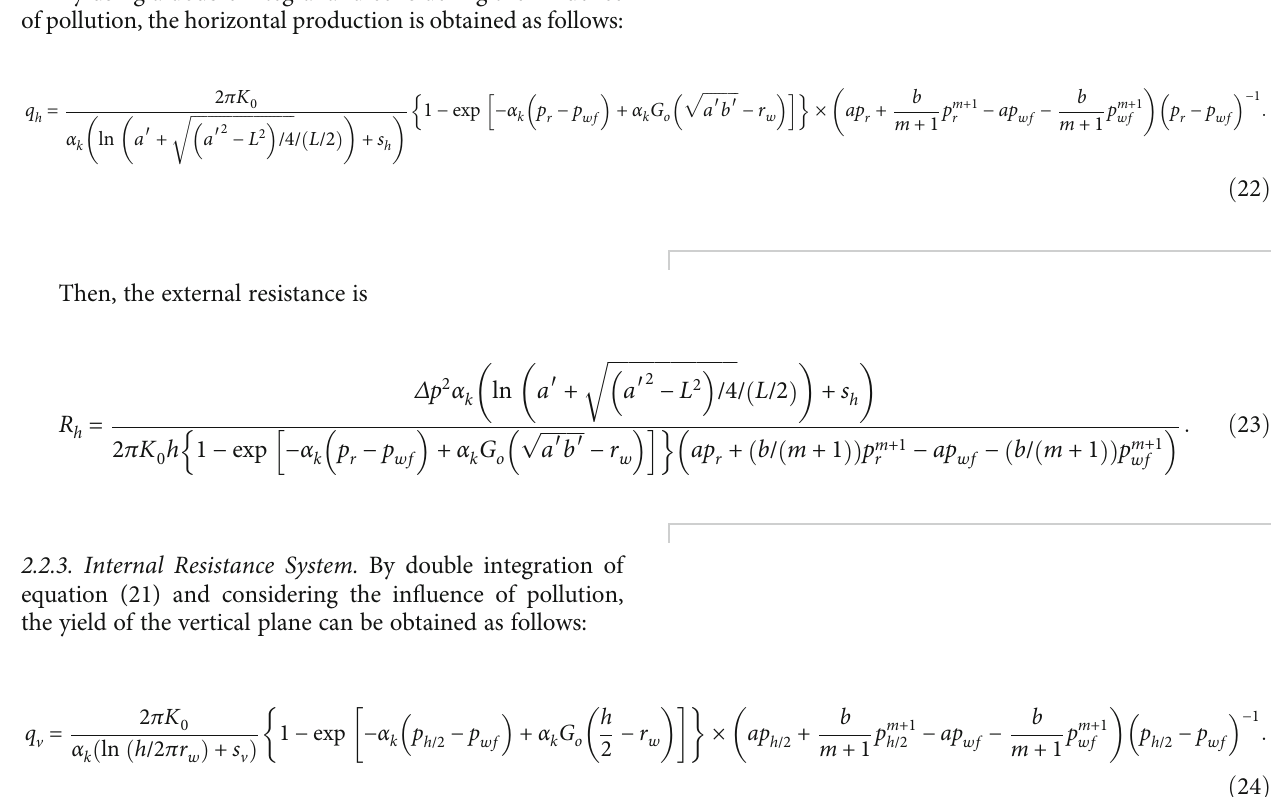
Figure 4: Mobility function curve.